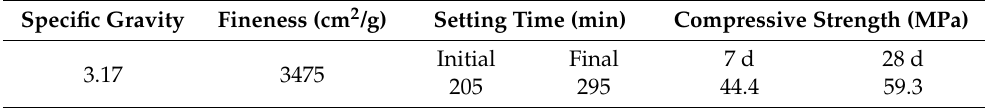
Table 1. Physical properties of cement.